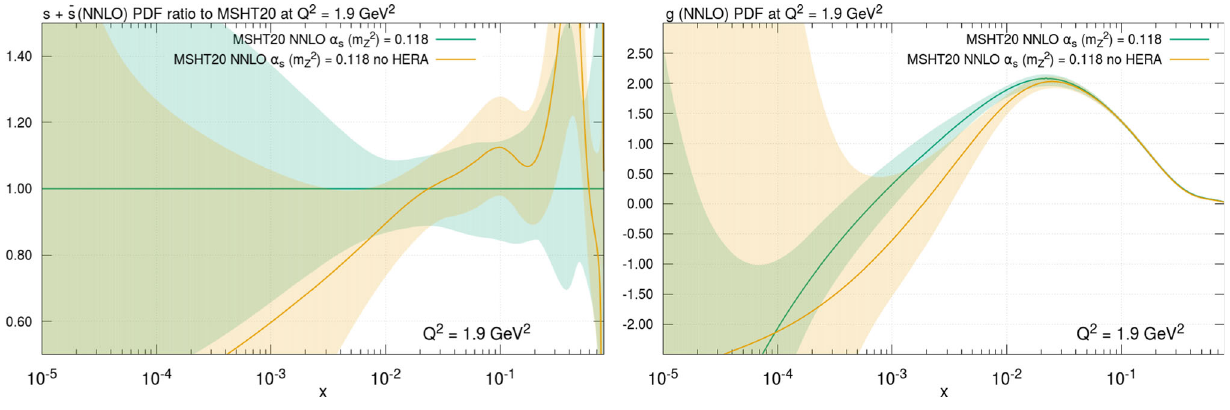
Fig. 75 (Left) s + ¯ s PDF ratio and (right) g PDF absolute value compared to the MSHT20 default at Q 2 = 1 . 9 GeV 2 at NNLO showing the effect of removing the HERA data from the MSHT20 default global fit